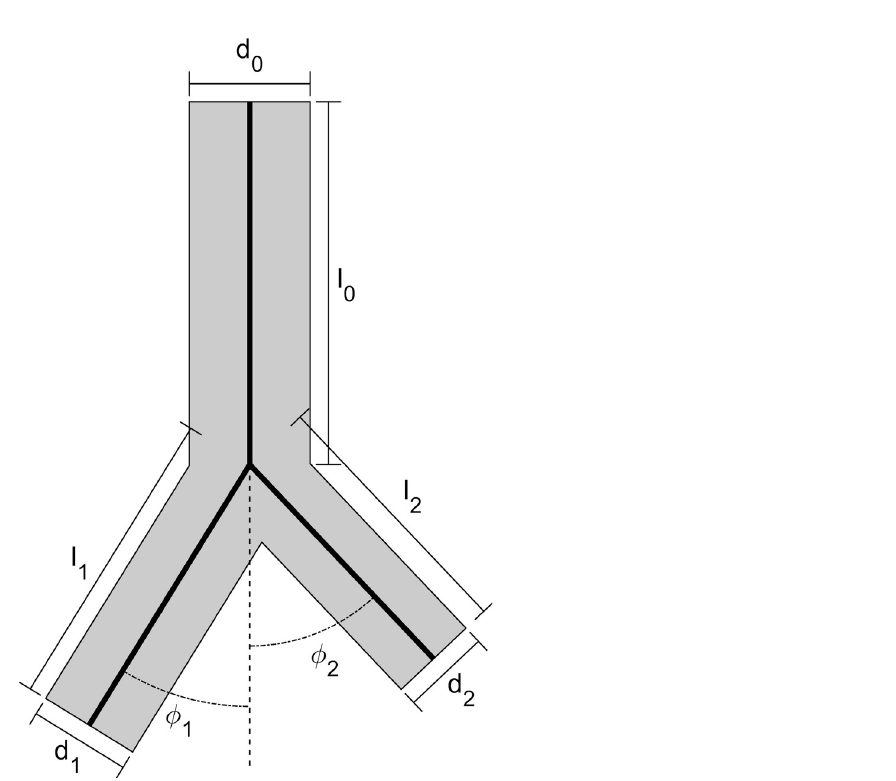
Fig 4. Bifurcation diagram. Bifurcation of 0 branch into two (1, 2) daughter branches. The cabal ratio for branch 1 is: q 1 = 0.6. Length is 3 times the diameter of each branch as may be seen in Eq 2. Diameter relations are obtained from Eq 4, as d 1 = 0.84 � d 0 and d 2 = 0.74 � d 0 . Angular values are computed using Eq 5, as ϕ 1 = 32˚ and ϕ 2 =